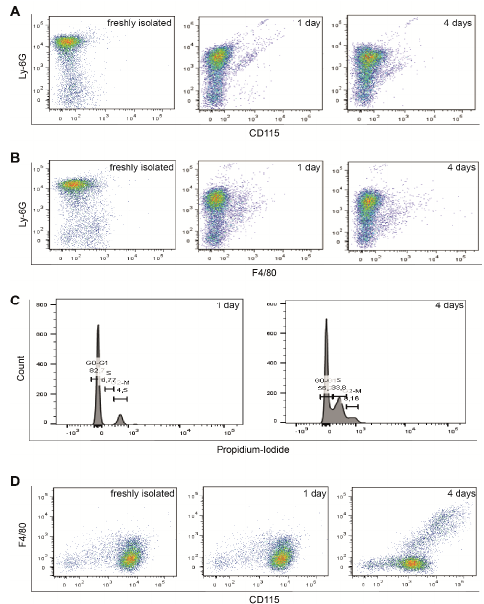
Figure 1. Validation of neutrophil and mononuclear fractions after isolation. The neutrophil fraction was positive for Ly-6G, but not for CD115 or F4/80 ( A ). Their phenotype did not change but was slightly shifted after 4 days in culture ( B ). The viability of the cells was not affected during culturing ( C ). Mononuclear fraction was positive for CD115 and showed differentiation potential towards macrophage after 4 days in culture ( D ). Int. J. Mol. Sci. 2019 , 20 , x FOR PEER REVIEW